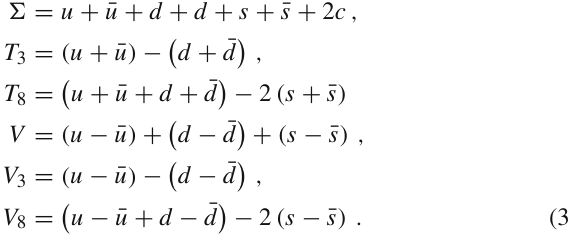
dataset is not included in the default NNPDF4.0 PDF set 2